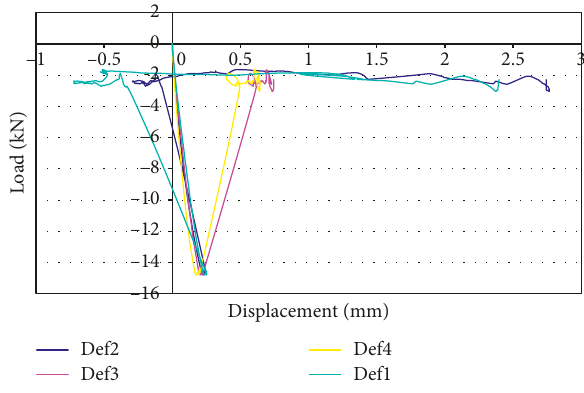
Figure 13: Load-displacement plot of the second triplet